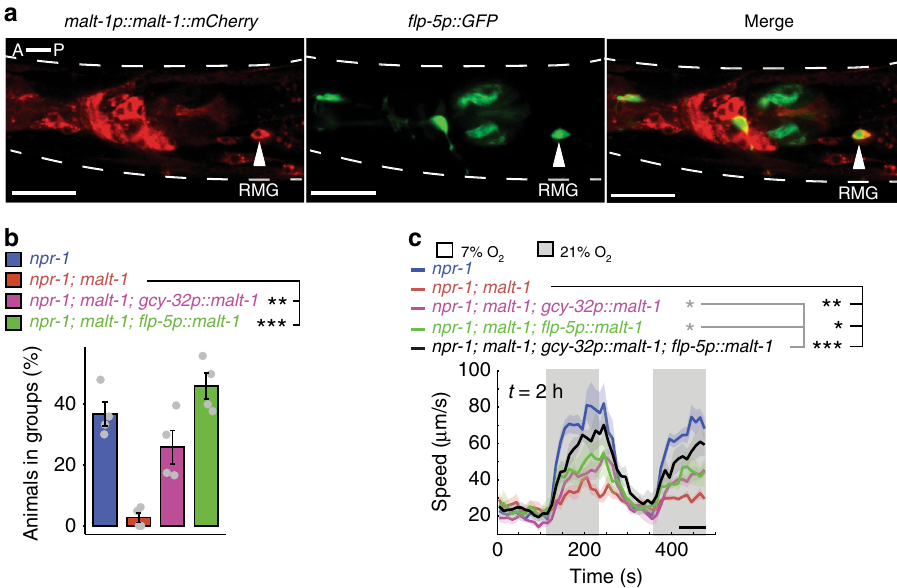
Fig. 3 MALT-1 functions in RMG interneurons. a A MALT-1::mCherry translational fusion, expressed from its endogenous promoter (4 kb), is expressed in RMG interneurons. RMG is recognized by its characteristic shape, location, and using a fl p-5p::gfp reporter. Similar results were obtained in 3 experiments. Scale bars: 20 μ m. b Expressing malt-1 cDNA from either the fl p-5 promoter (RMG, ASG, PVT, I4, M4, and pharyngeal muscle), or the gcy-32 promoter (URX, AQR and PQR) rescues the aggregation defect of malt-1 mutants. N = 4 assays. Data are presented as mean values + / − SEM. ** P < 0.01, *** P < 0.001, one-way ANOVA with Tukey ’ s post hoc HSD. c The O 2 -response defect of malt-1 mutants is partially rescued by expressing malt-1 cDNA from the fl p-5 promoter (RMG, ASG, PVT, I4, M4, and pharyngeal muscle), or the gcy-32 promoter (URX, AQR and PQR), and almost completely rescued when malt-1 is expressed from both promoters simultaneously. Lines indicate average speed and shaded regions indicate SEM. n = 55 animals ( npr-1 ), n = 85 animals ( npr-1; malt-1 ), n = 58 animals ( npr-1; malt-1; gcy-32p::malt-1 ), n = 66 animals ( npr-1; malt-1; fl p-5p::malt-1 ), n = 46 animals ( npr-1; malt-1; gcy-32p:: malt-1, fl p-5p::malt-1 ). Plots show average speed (line) and SEM (shaded regions). * P < 0.05, ** P < 0.01, *** P < 0.001, two-sided Mann-Whitney U